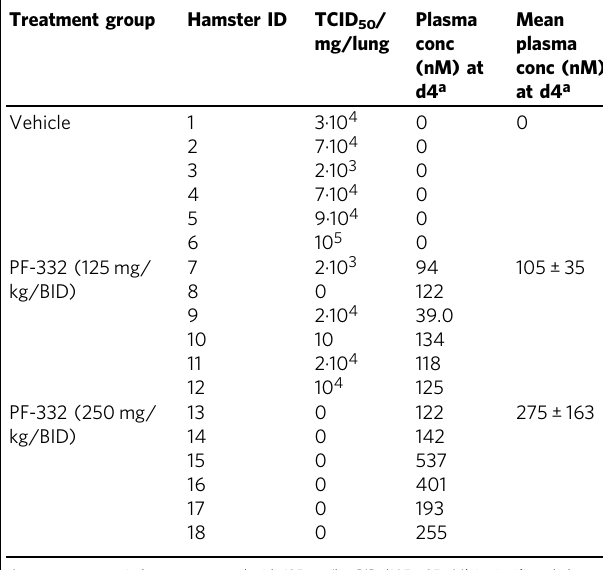
Table 2 Comparison of PF-332 exposure in plasma at sacri fi ce (4 days post-infection) with infectious virus titers in